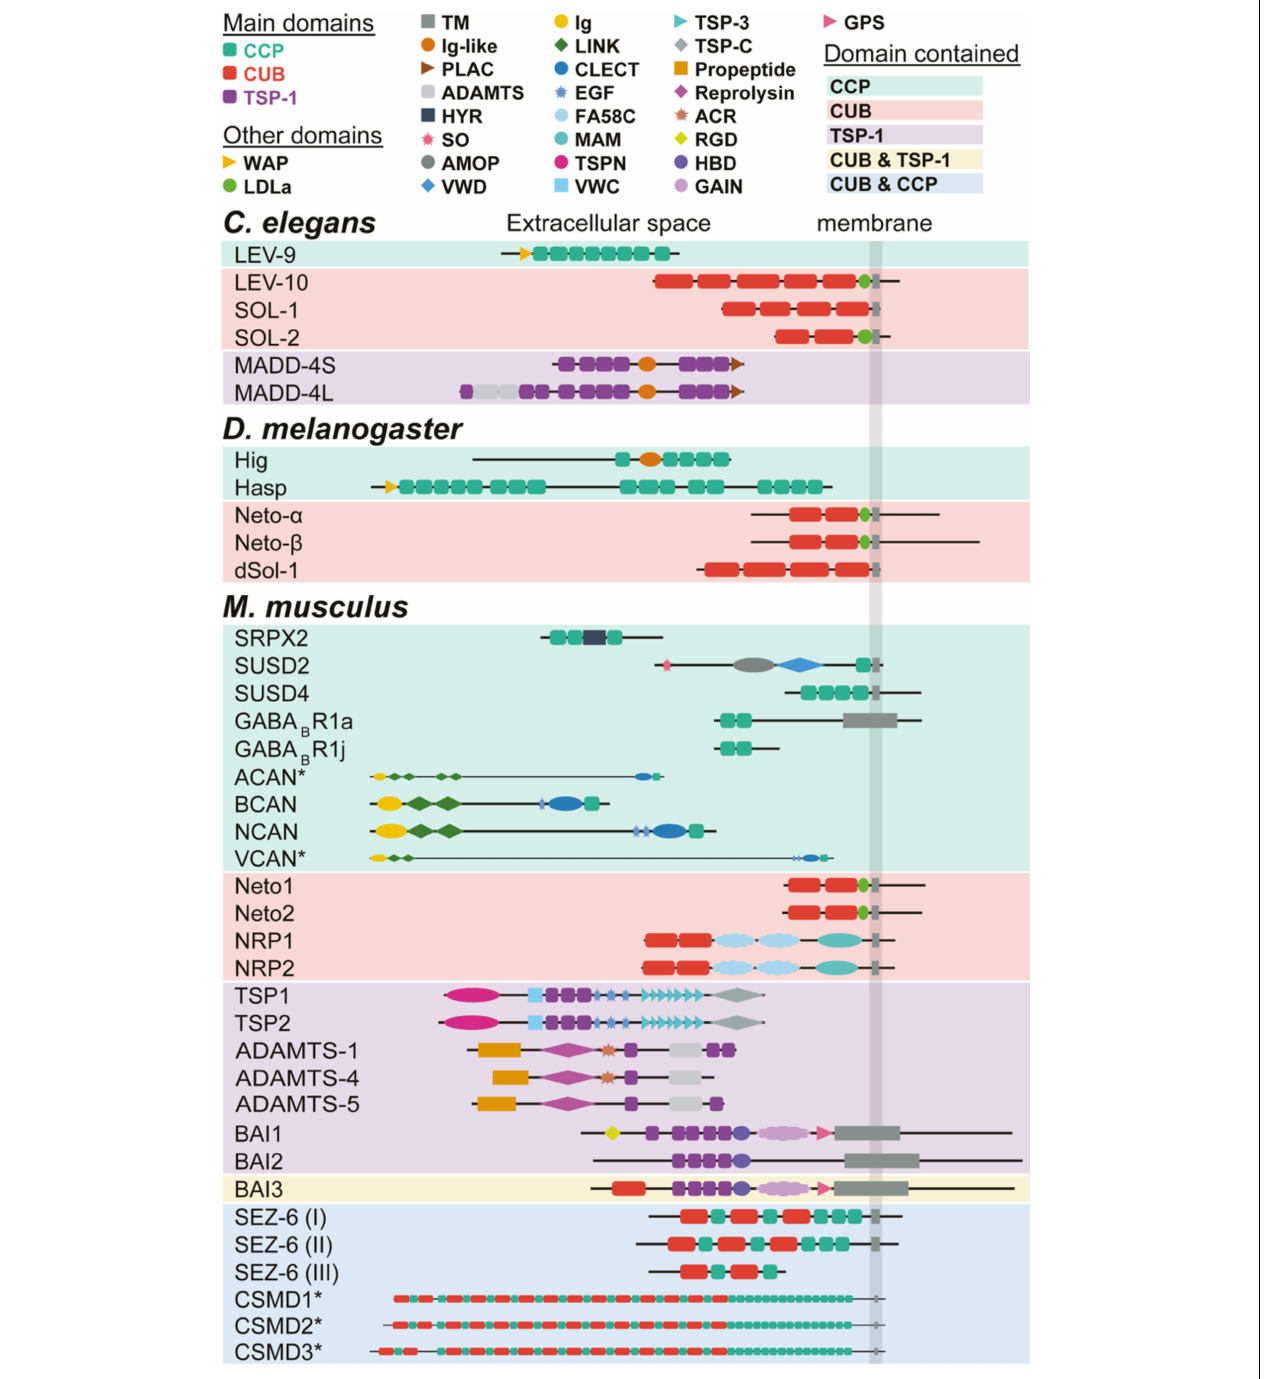
FIGURE 2 | CCP, CUB, and TSP-1 domain-containing proteins with known synaptic functions in C. elegans , D. melanogaster and M. musculus . Domain structure is indicated for each protein and proteins are grouped depending on their CCP, CUB, and/or TSP-1 domain content. * indicates a 1:2 scale for the protein.